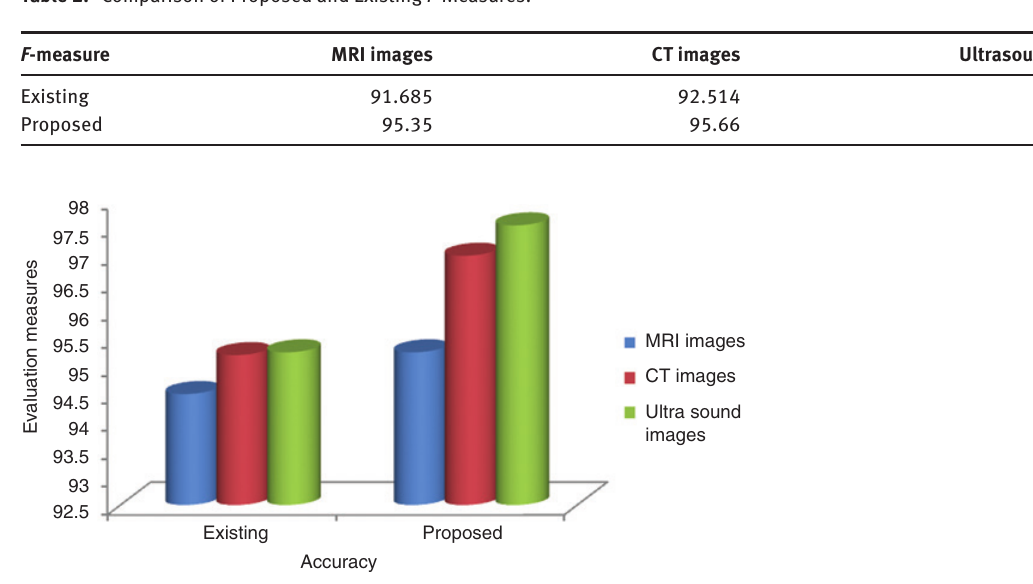
Figure 11: Comparison of Evaluation Measures for